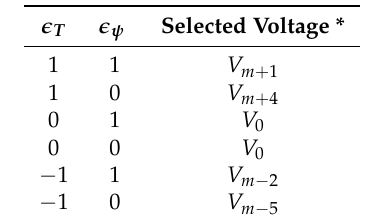
Figure 3. The α − β (top side) and the z 1 − z 2 (down side) vector subspaces for a six-phase VSI. Table 1. Switching table of DTC strategy.